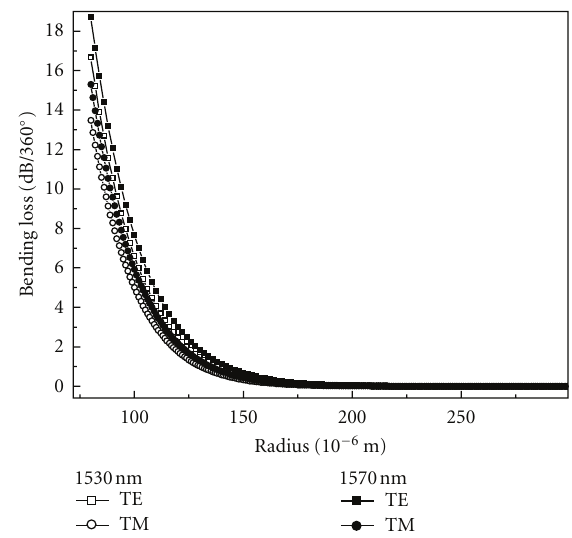
Figure 2: The bending losses per turn as a function of the ring radius at wavelength of 1530 nm and 1570 nm for TE and TM